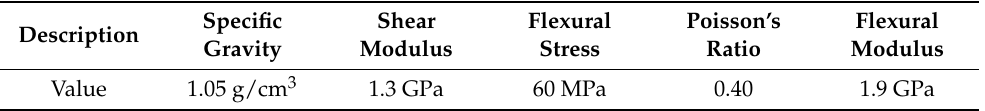
Table 3. Properties of the epoxy resin